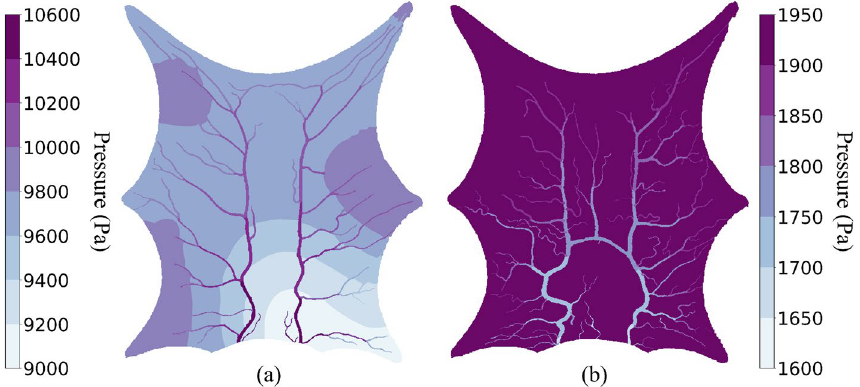
Figure 6. For ǫ = 10mm ( a ) arterial compartment pressure of Layer 1. ( b ) Venous compartment pressure of Layer 3.